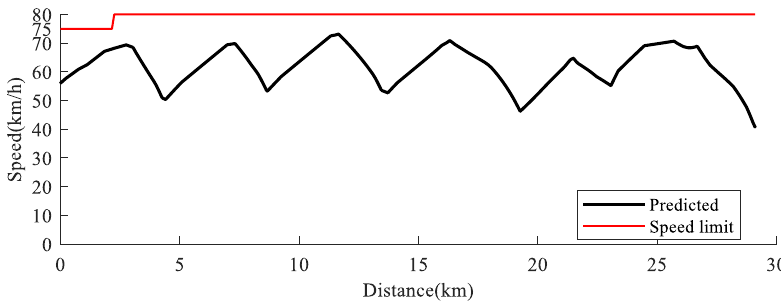
Figure 10. Scenario 1: train operation curve under predicted control strategy.